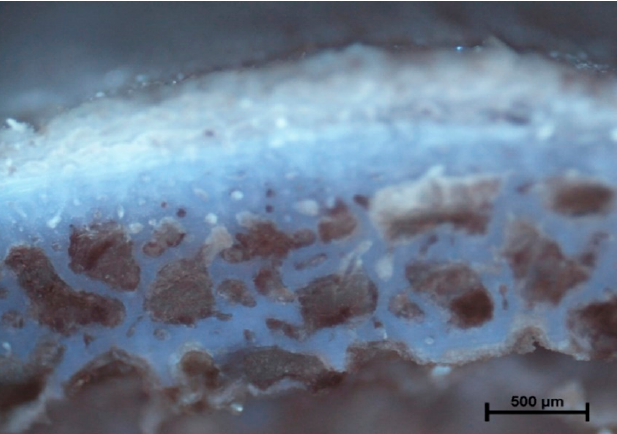
Figure 7. Rotation 1200 rpm (20 °C). Total destruction of bone tissue and bone marrow. Visible empty bone marrow cavity (arrow) and debris of trabecular architecture of bone.